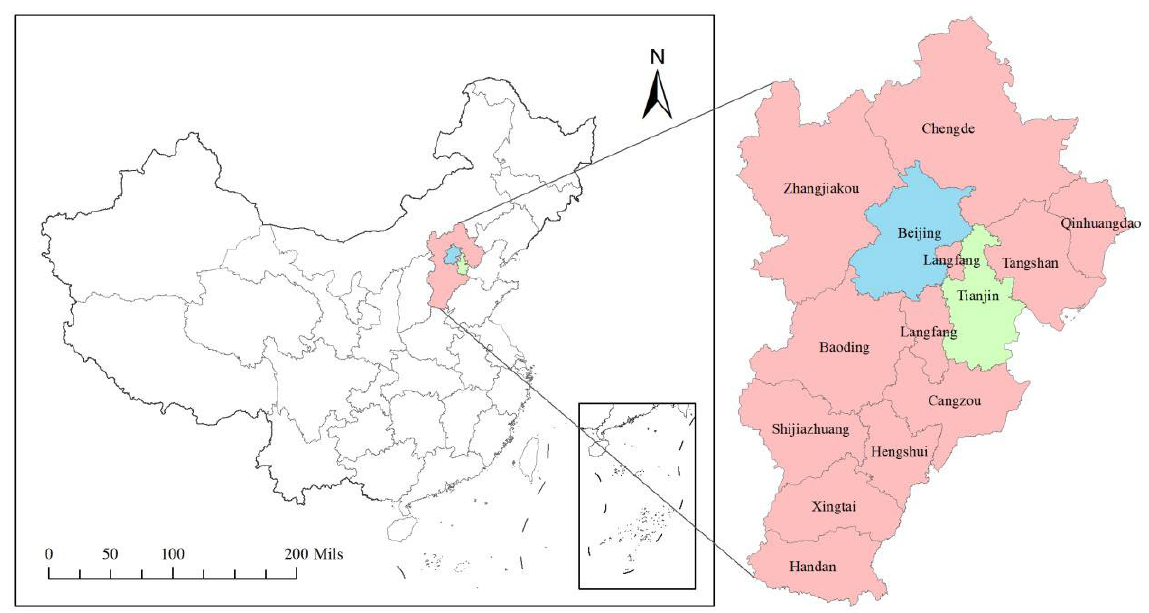
Figure 2. Overview map of the BTH in China. Figure source: authors’ own creation.